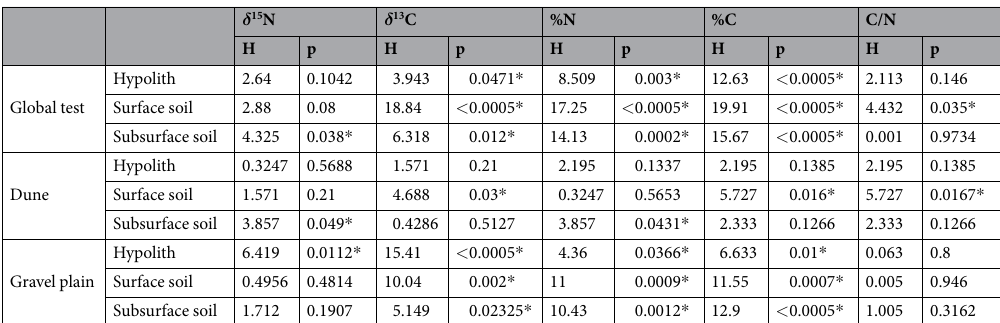
Table 3. Kruskal-Wallis H test results testing the effect sample moisture source (fog vs rain) on the C and N chemistries of samples from the Namib Desert environments tested globally or when originating from different habitats (dune vs gravel plain). H: Kruskal-Wallis test H(chi 2 ) statistic. * Significantly different (p <